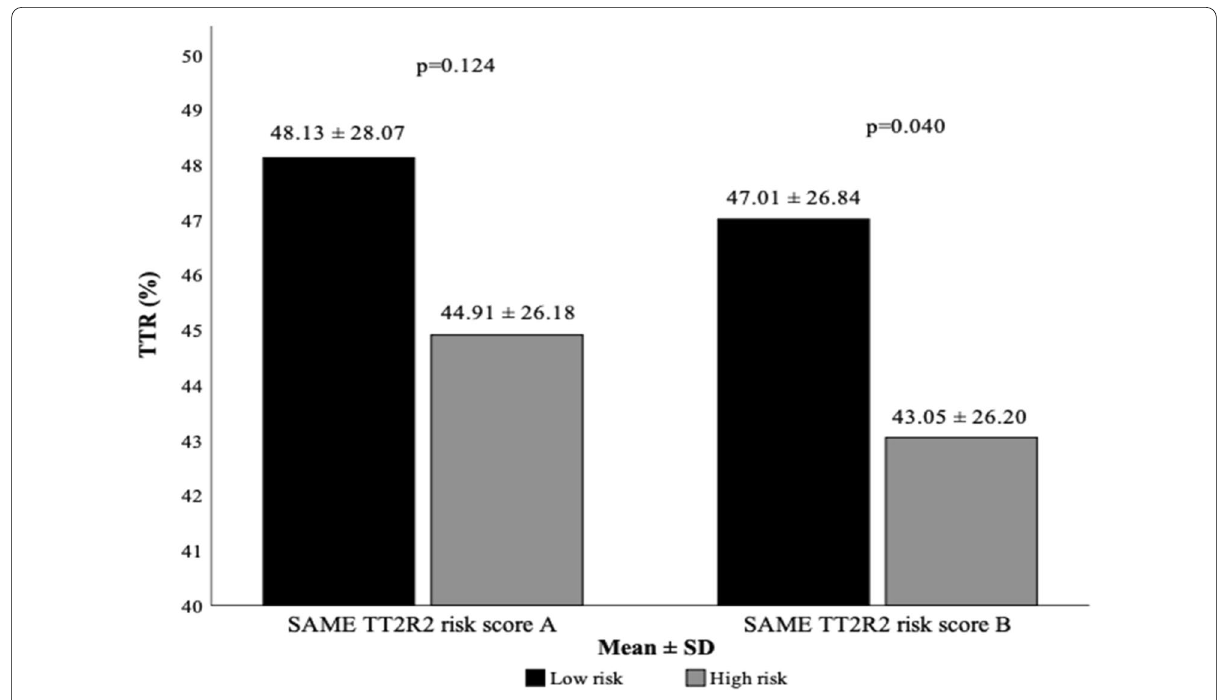
Fig. 3 TTR (mean SD) for high and low risk group of the SAMeTT2R2 ±